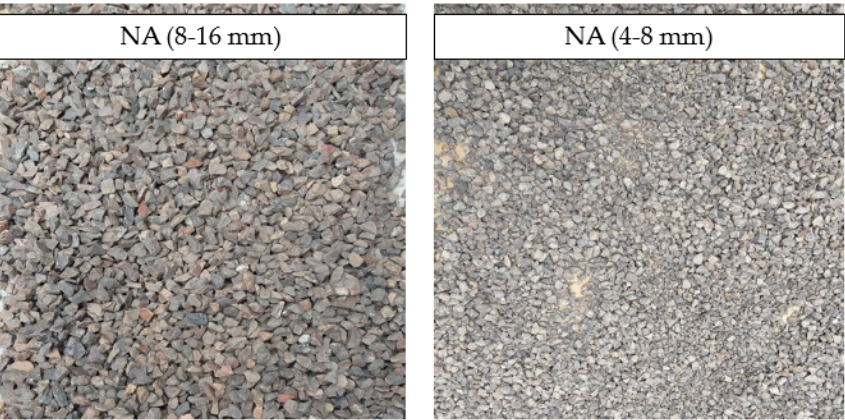
Figure 2. Natural aggregate (NA): dolomite fractions of 8 – 16 mm (on the left ) and 4 – 8 mm (on the right ).